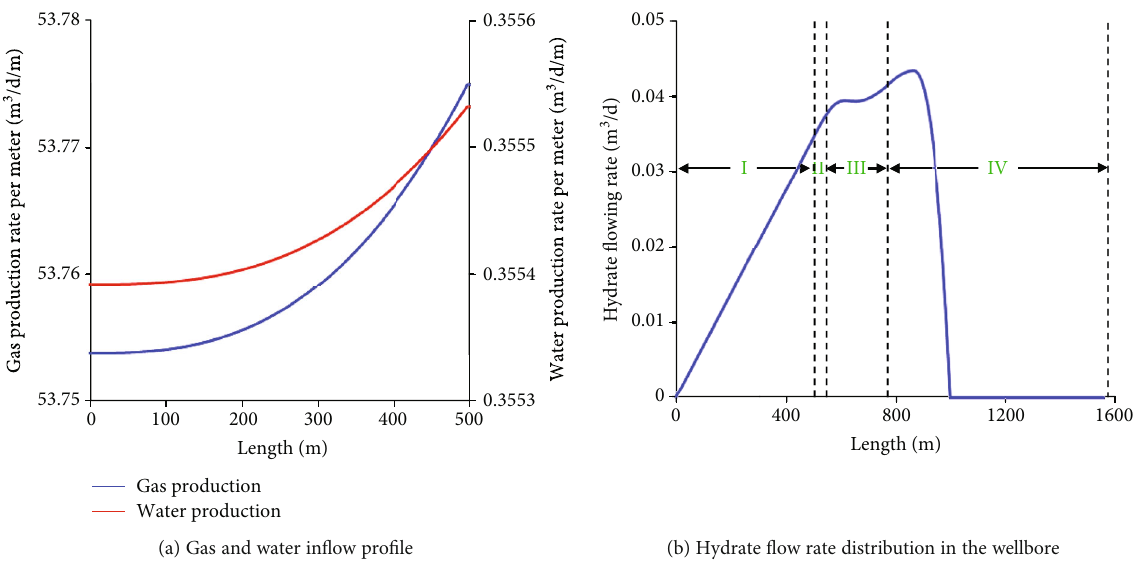
Figure 7: Gas and water in fl ow pro fi le and hydrate fl ow rate distribution in the